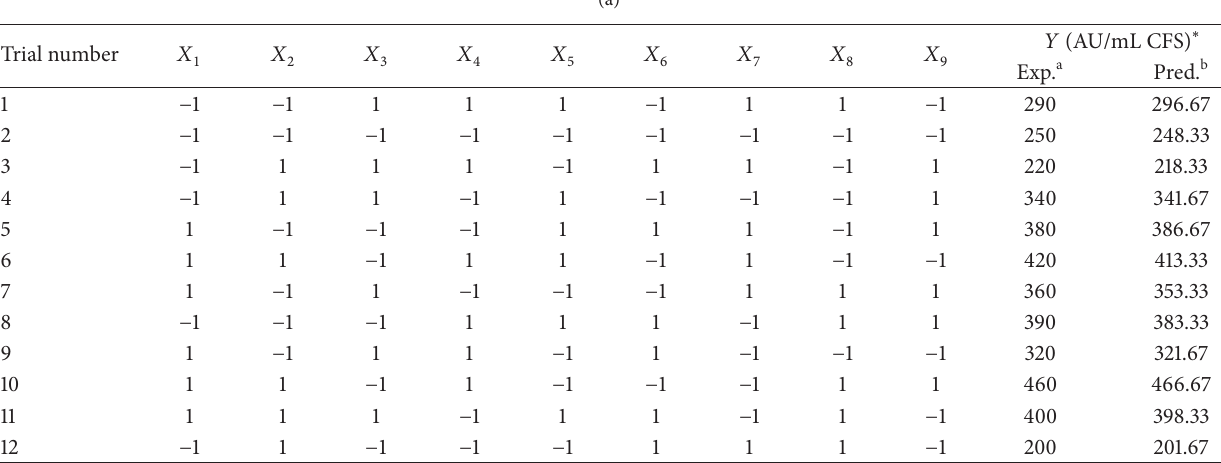
Table 3: (a) PBD with coded levels of nine independent variables and experimental versus predicted levels of BAC YAS 1. (b) Real-coded values of independent variables and regression analysis for BAC YAS 1 optimization by